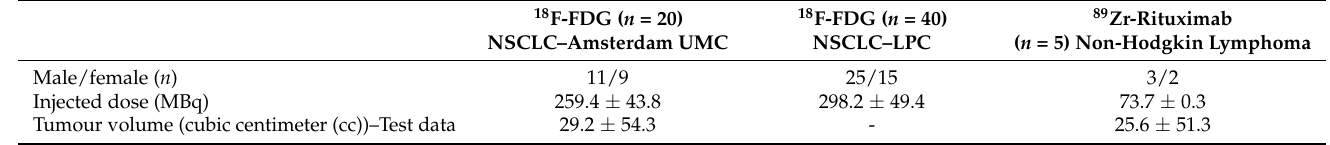
Table 1. The patients characteristics included in this study from Amsterdam